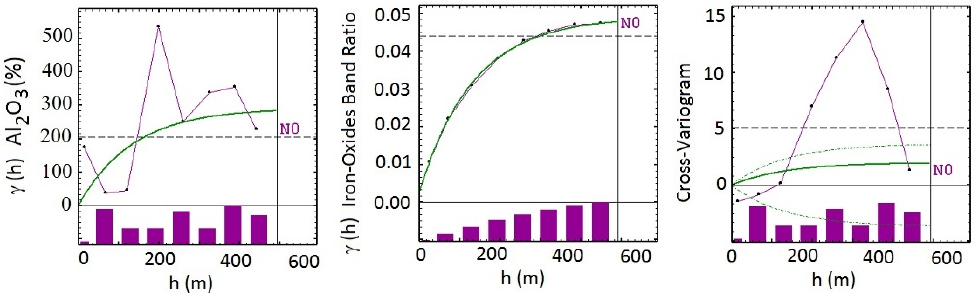
Figure 9. Direct and cross sample variogram (purple) and the fitted model (green line) based on aluminum samples and iron oxides band ratio from Sentinel-2 Image.